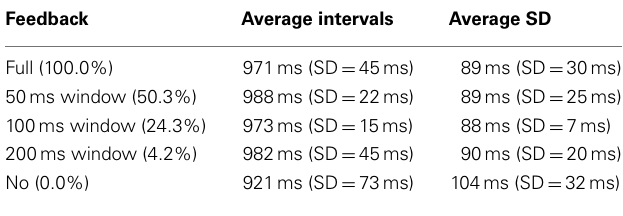
Table 1 |Averages and average SD of time interval estimates.